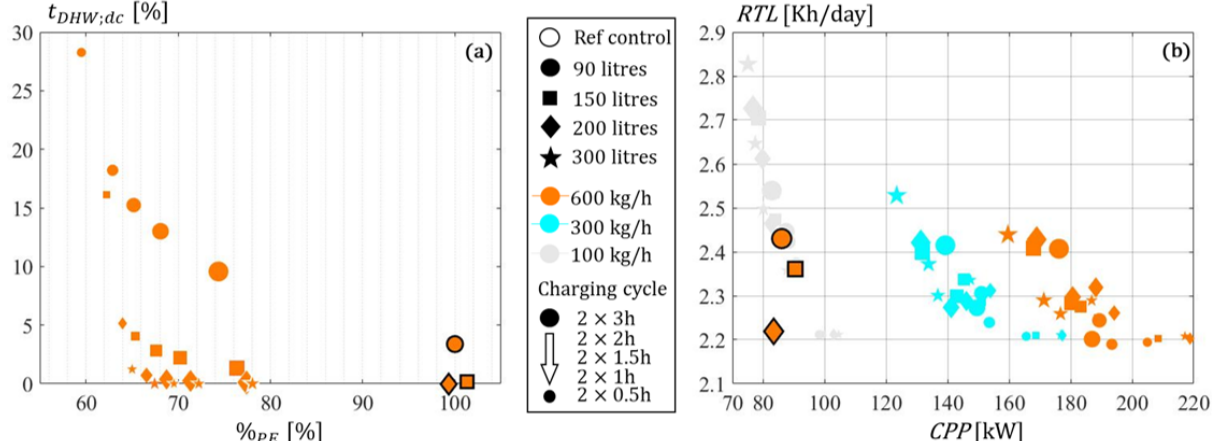
Figure 6. TB-control: ( a ) a Pareto plot of t DHW ; dc and % PE with a ˙ m ch of 600 kg/h, and ( b ) a Pareto plot of room temperature lack (RTL) and central peak power (CPP). The shape refers to the DHW storage volumes (90 L, 150 L, 200 L, and 300 L). The reference is outlined in black. The ˙ m ch defines the potential PE savings, but also highly affects the DHW discomfort. The CPP can be reduced to the reference control level by lowering ˙ m ch .